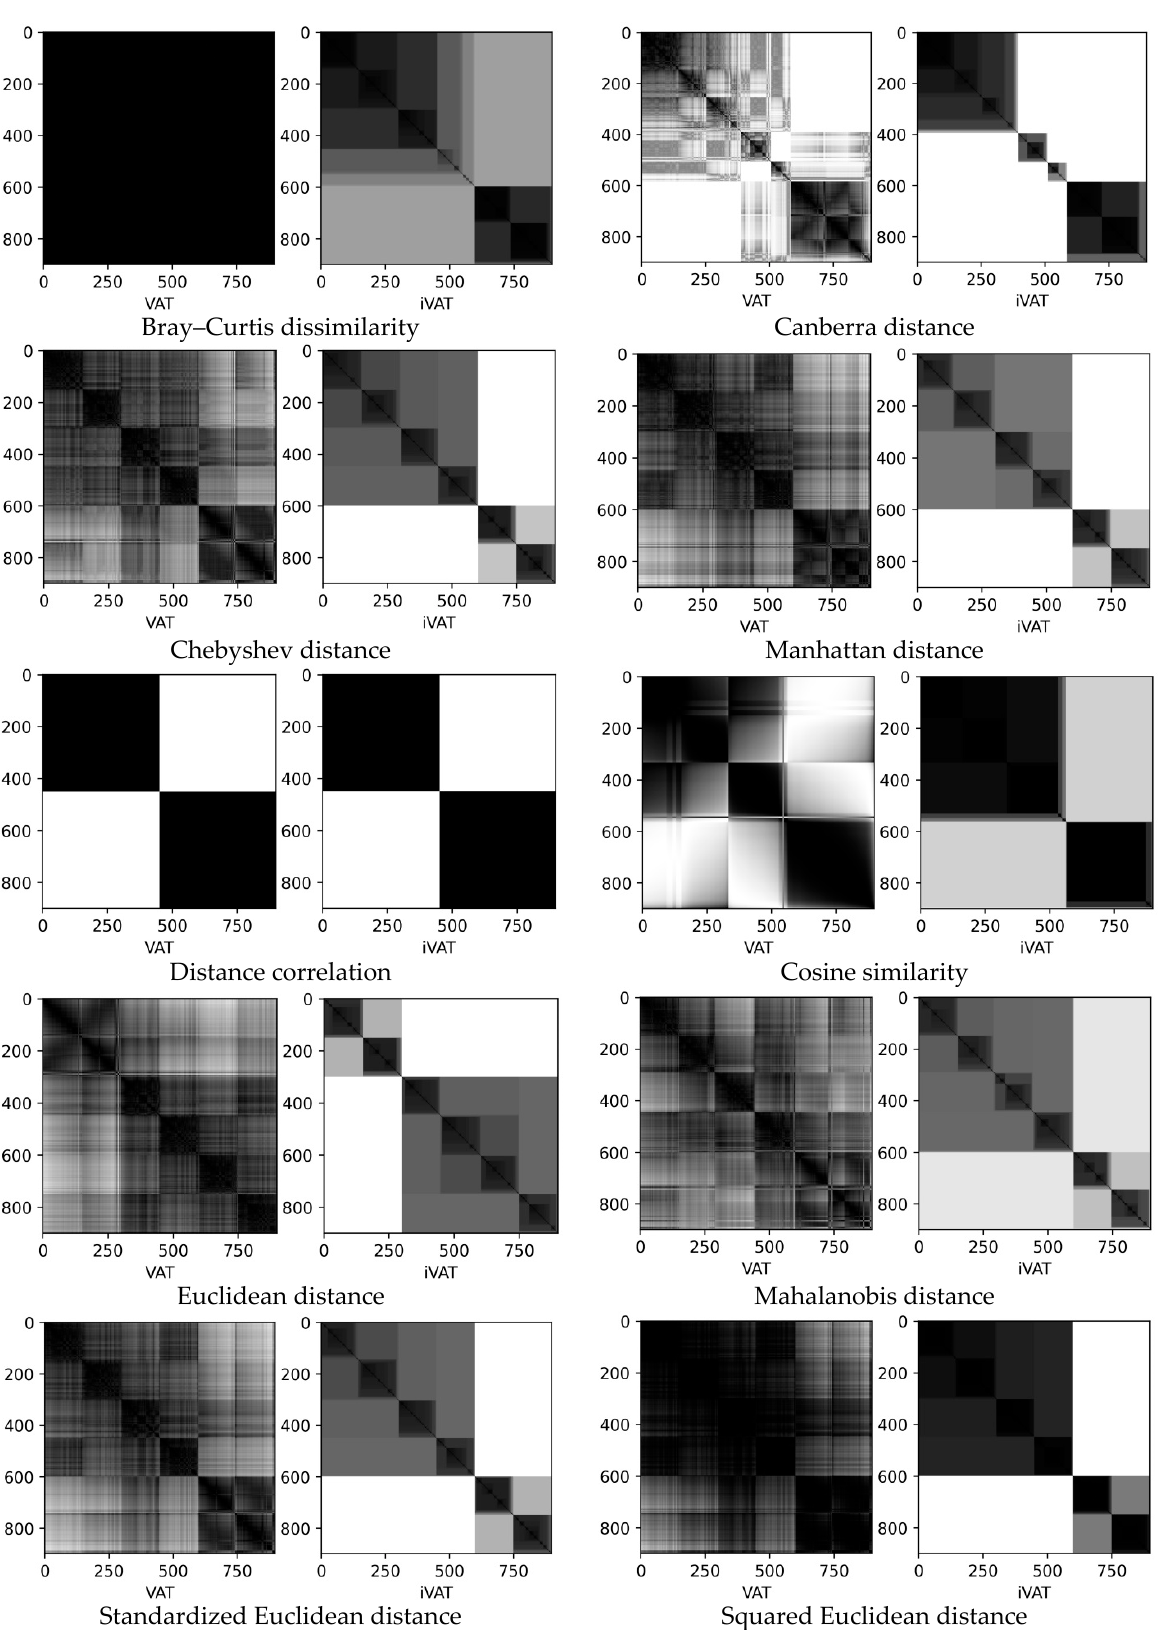
Figure A3. Longsquare. Cluster heat map.